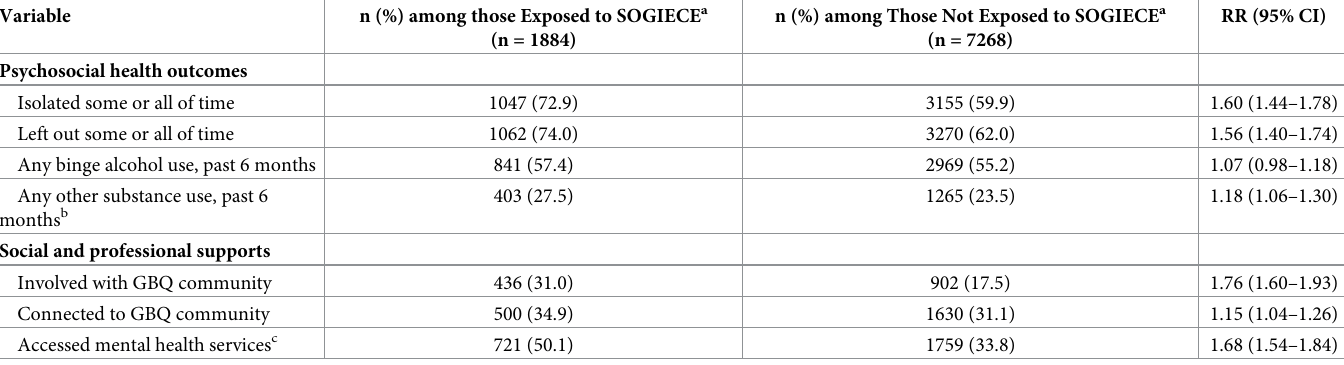
Table 6. Psychosocial health outcomes and social and professional support access associated with exposure to Sexual Orientation and Gender Identity Change Efforts (SOGIECE) among sexual minority Canadian men.